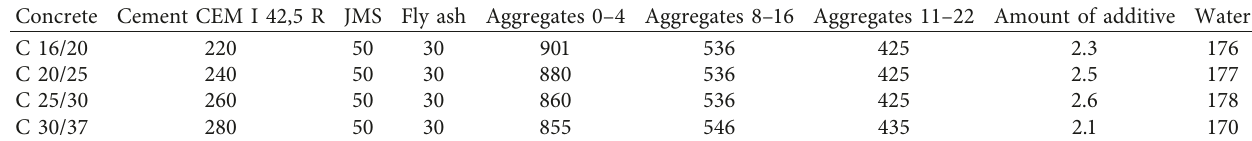
Table 3: Composition of the referential concrete mixture in kg per m 3 [19].